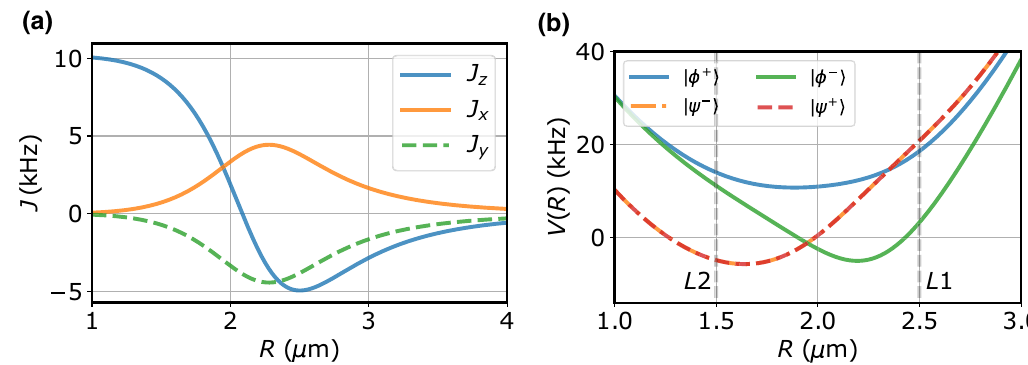
FIG. 4. (a) The spin pattern, corresponding to the coefficients of Eq. (20), for the parameters n = 60, (cid:10) − = − (cid:10) + = 2 π × 50 MHz and (cid:11) − = (cid:11) + / 3 = 2 π × 3 MHz. (b) Collective spin-dependent potential landscapes. Each trace corresponds to a Bell state of the qubot nucleus. Corrective devices L 1 and L 2 are positioned outside the potential minima as, for example, the dashed vertical lines indicate.